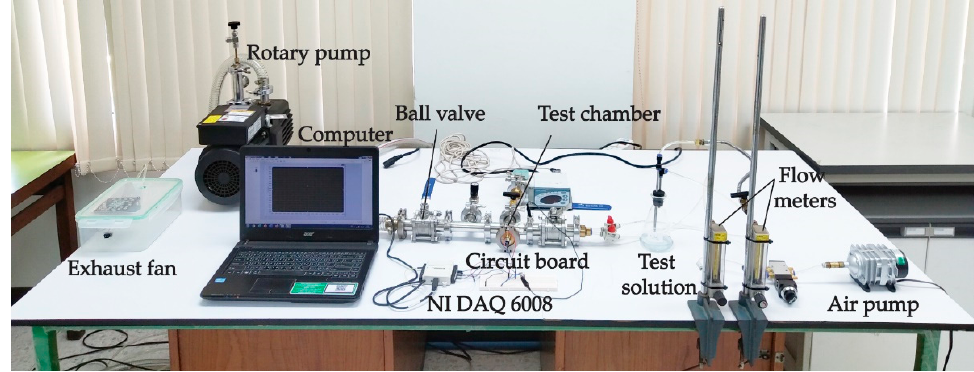
Figure 2. Photograph of gas-measurement system in this study.